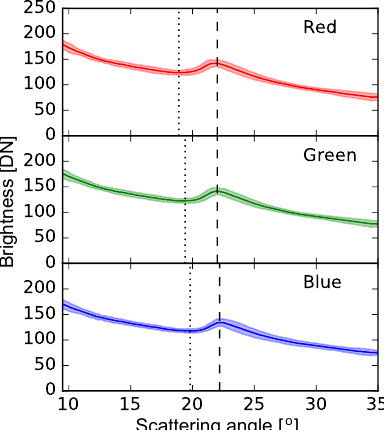
Figure 5. HaloCam image processing demonstrated for the mea- surements shown in Fig. 4, segment no. 4. The three panels show the brightness distributions (in digital numbers, DN) for the red, green and blue image channel as a function of the scattering angle. The solid line represents the brightness averaged azimuthally over the image segment, whereas the shading indicates the 2 σ standard deviation. The vertical lines pinpoint the scattering angles of the 22 ◦ halo minimum (dotted) and maximum (dashed) for the RGB